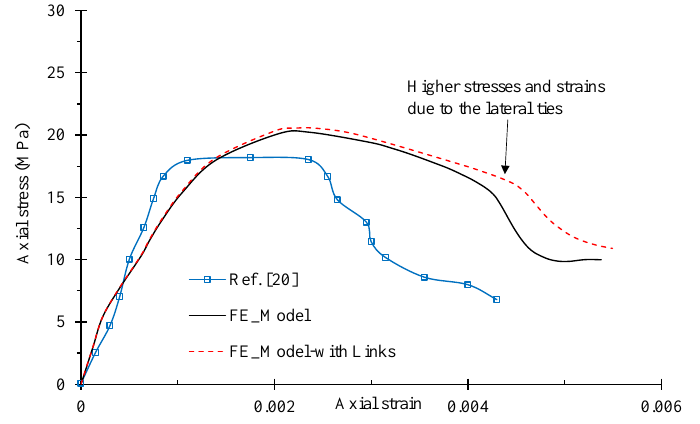
Figure 11. Comparison of finite element model with experimental results of a control column of reference [20].